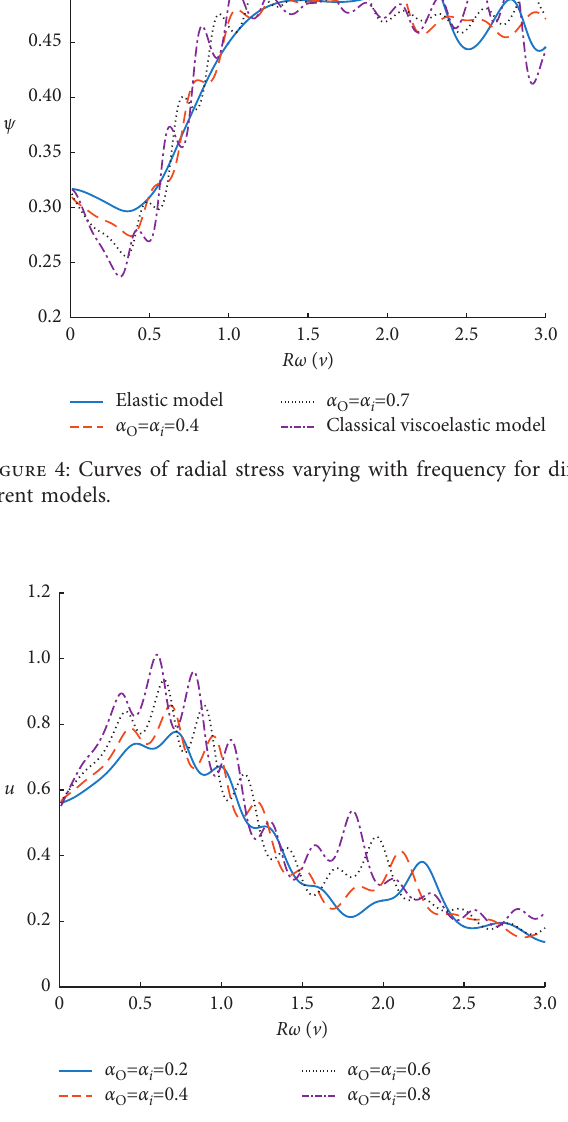
Figure 7: Curves of radial displacement varying with frequency for different shear modulus ratio of affected